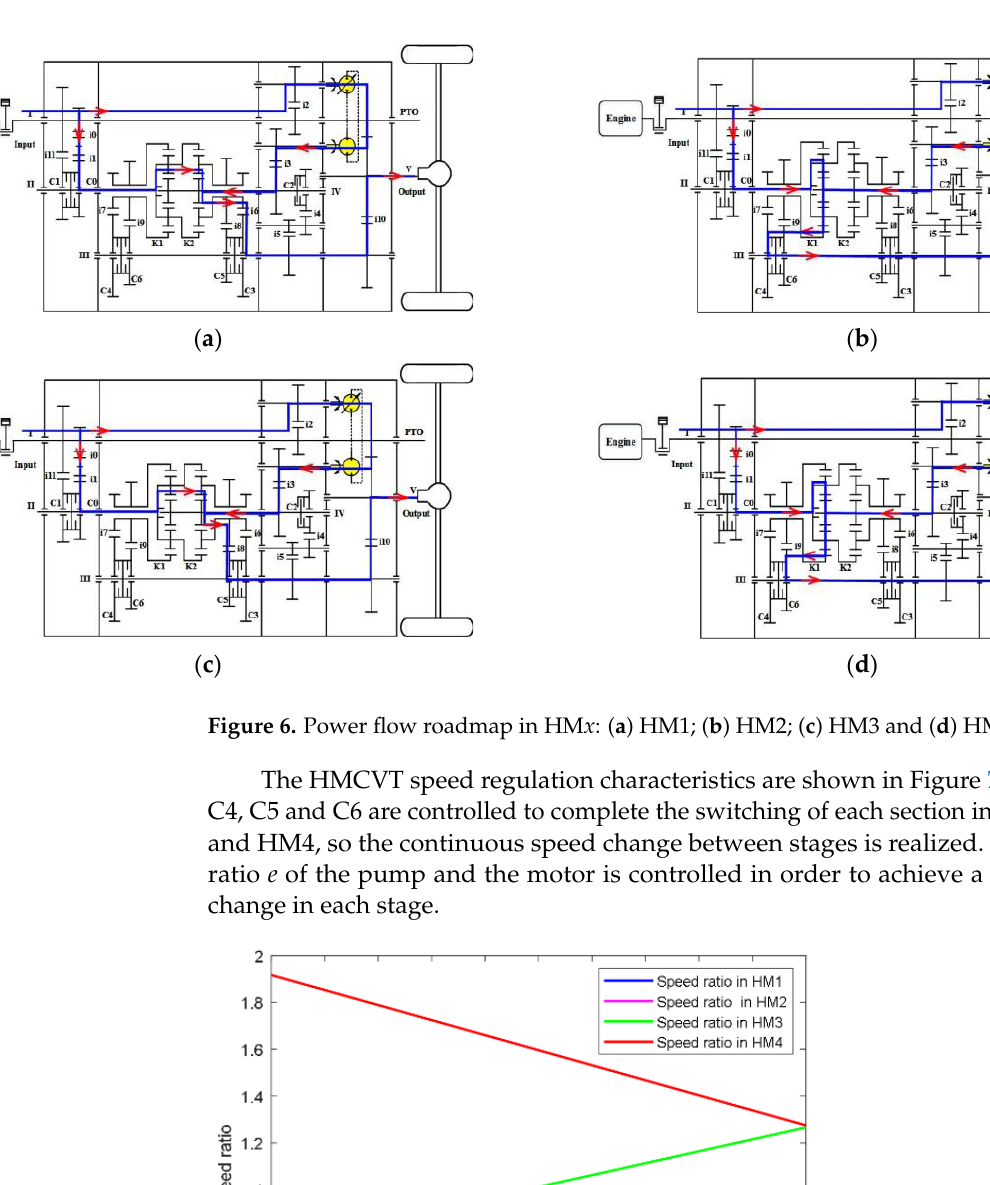
(Appendix B). The transmission ratio of each transmission gear pair and the value of k are calculated as shown in Table 5. Table 5. Gearbox gear pair transmission ratio and k value. Parameter